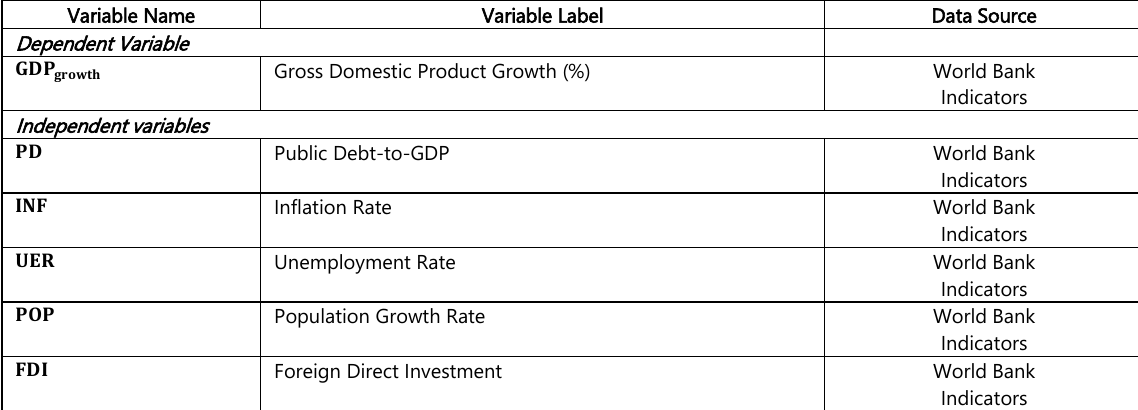
Table 1: Variable Definitions and Data Source (Source: Authors’